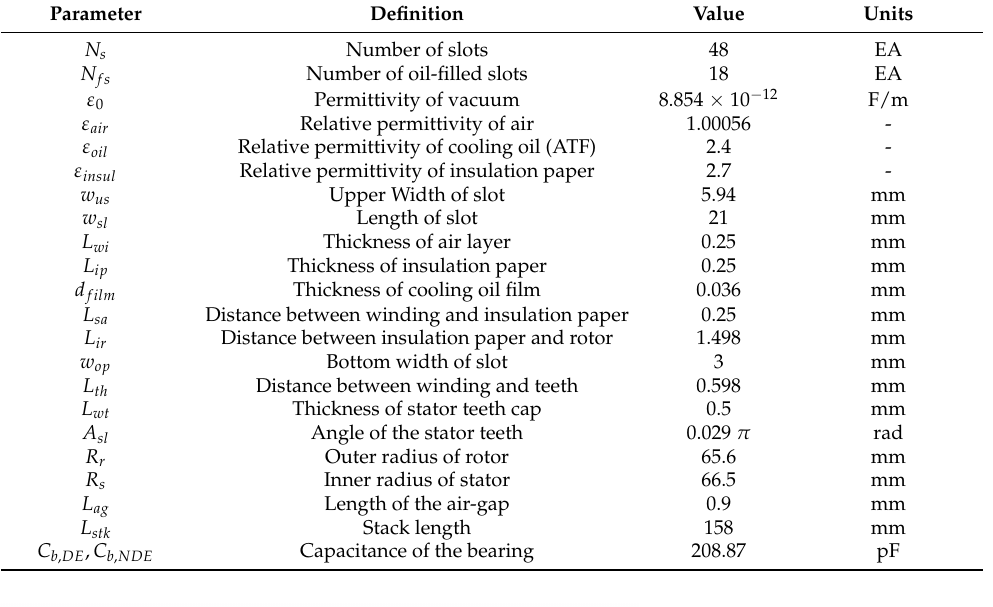
Table 2. Design parameters of the analyzed traction motor.